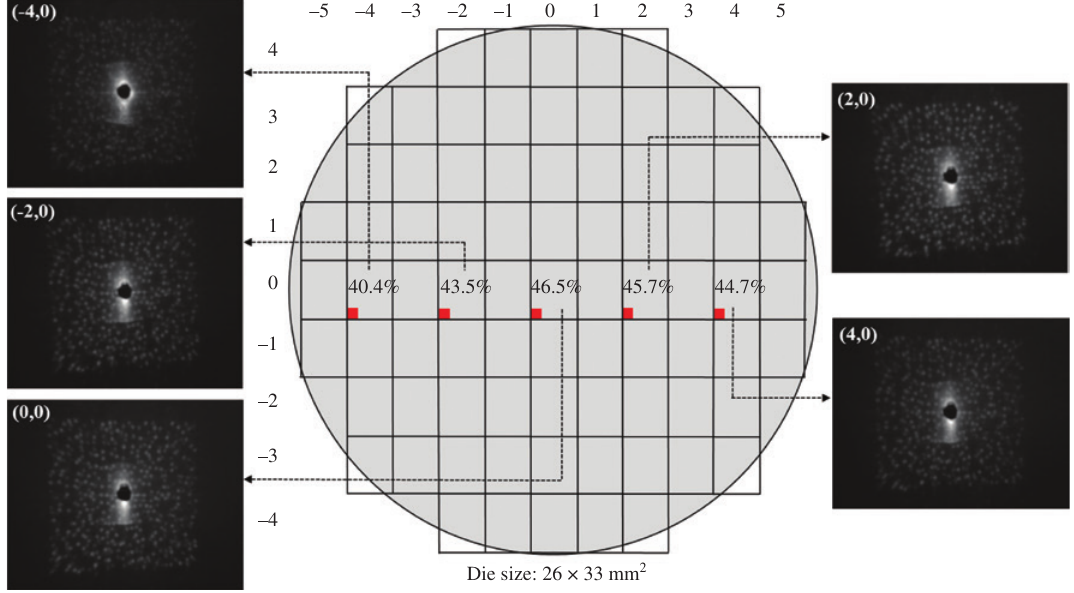
Figure 5: Wafer-level device performance uniformity measurement, showing the deflection efficiency measured in the central row. At locations (0, −4), (0, −2), (0, 0), (0, 2) and (0, 4), the deflection efficiencies are measured to be 40.4%, 43.5%, 46.5%, 45.7% and 44.7%, respectively. The random points images captured by the IR camera show a slight difference in brightness contributed by the difference in deflection